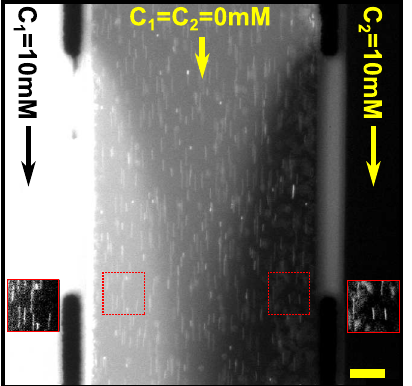
FIG. 2. (See Video 1.) HMMs are permeable to small- molecule solutes, yet admit no measurable hydrodynamic flow. Here, we use the three-channel device shown in Fig. 1(b) and specifically show the same close-up view as Fig. 1(c). All channels contain a fluorescent pH indicator at the same concen- tration, and each channel is buffered at a different pH: 8.1 (left, bright), 6.3 (center, intermediate), and 4.7 (right, dark), with ionic strengths balanced. Fluorescent tracer particles (bright lines) travel in straight lines past the center channel, indicating no convective inflow through either the left or right HMM.